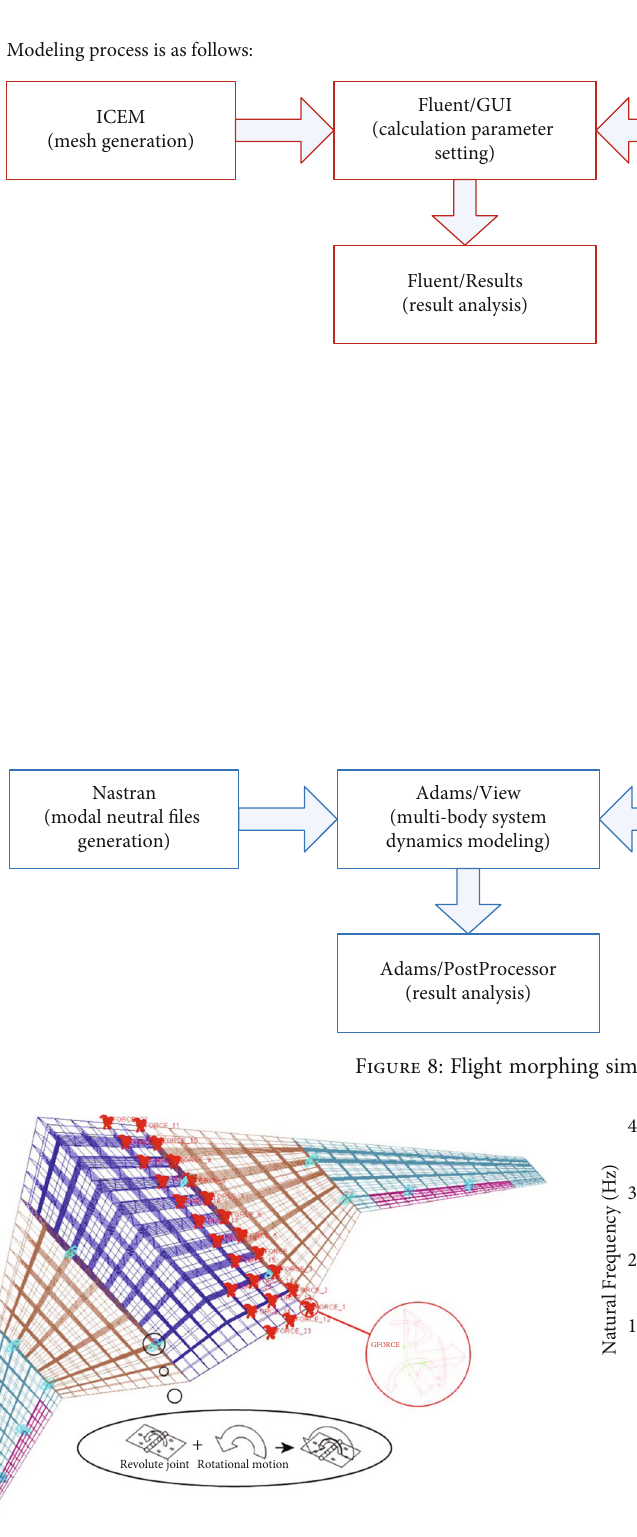
Figure 9: Adams model of the folding wing aircraft. Figure 10: Comparison of natural